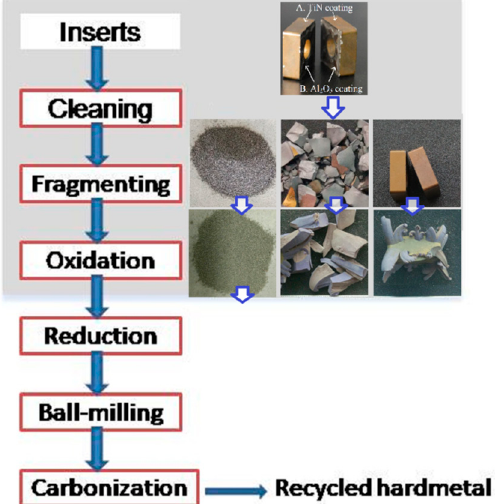
Figure 2. Recycling of coated multicomponent cemented carbides by the oxidation and reduction– carbonization process.